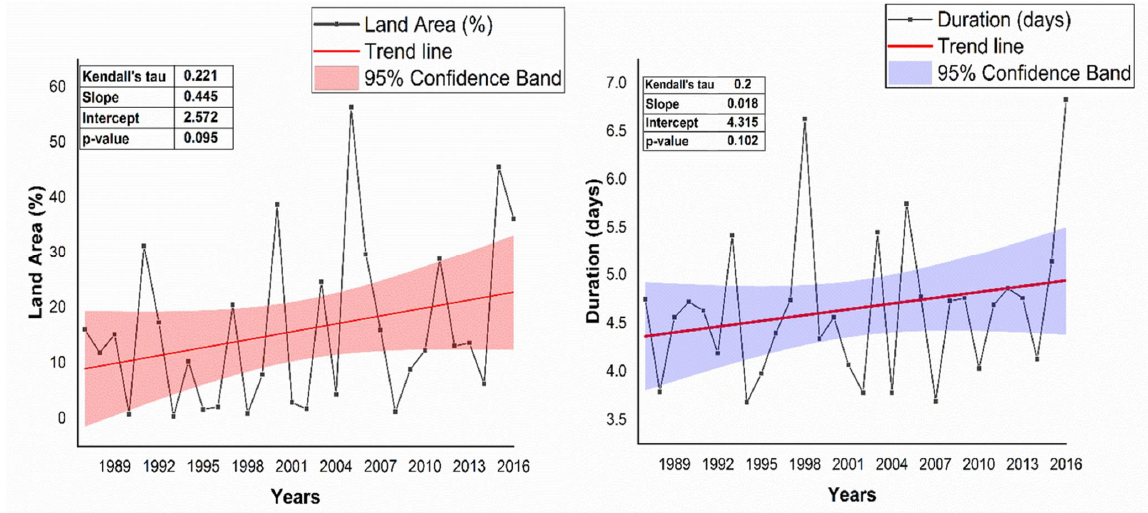
Figure 5. Average Trend in heatwaves affected areas ( left ) and duration ( right ).